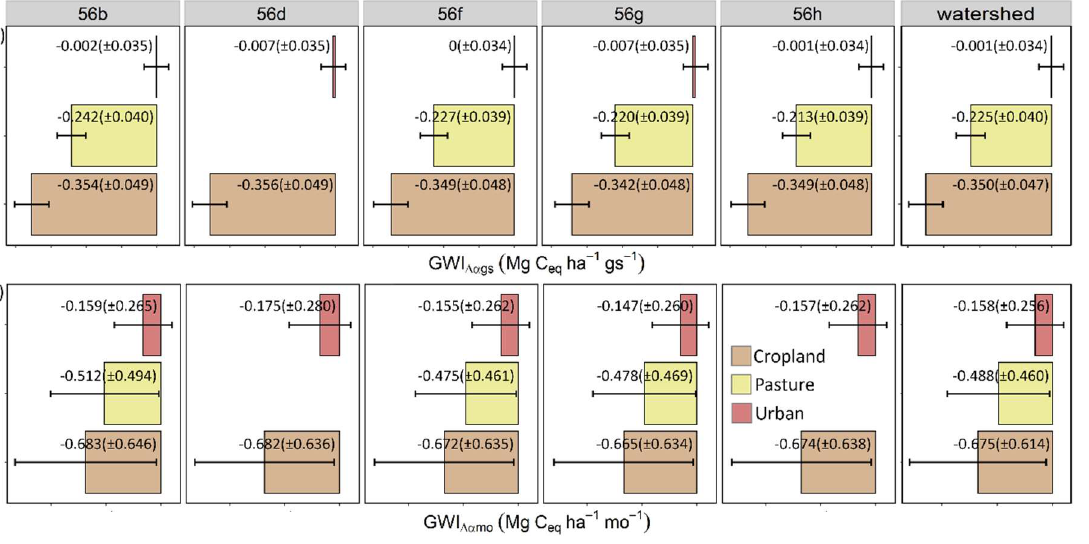
Figure 3. Albedo-induced global warming impact (GWI Δα ) for ( a ) growing season (GWI Δαgs ) and ( b ) monthly (GWI Δαmo ) periods, within the five Level IV ecoregions and the entire Kalamazoo River Watershed 2001–2019. Annotations indicate mean (±standard deviation) of GWI Δαgs and GWI Δαmo .